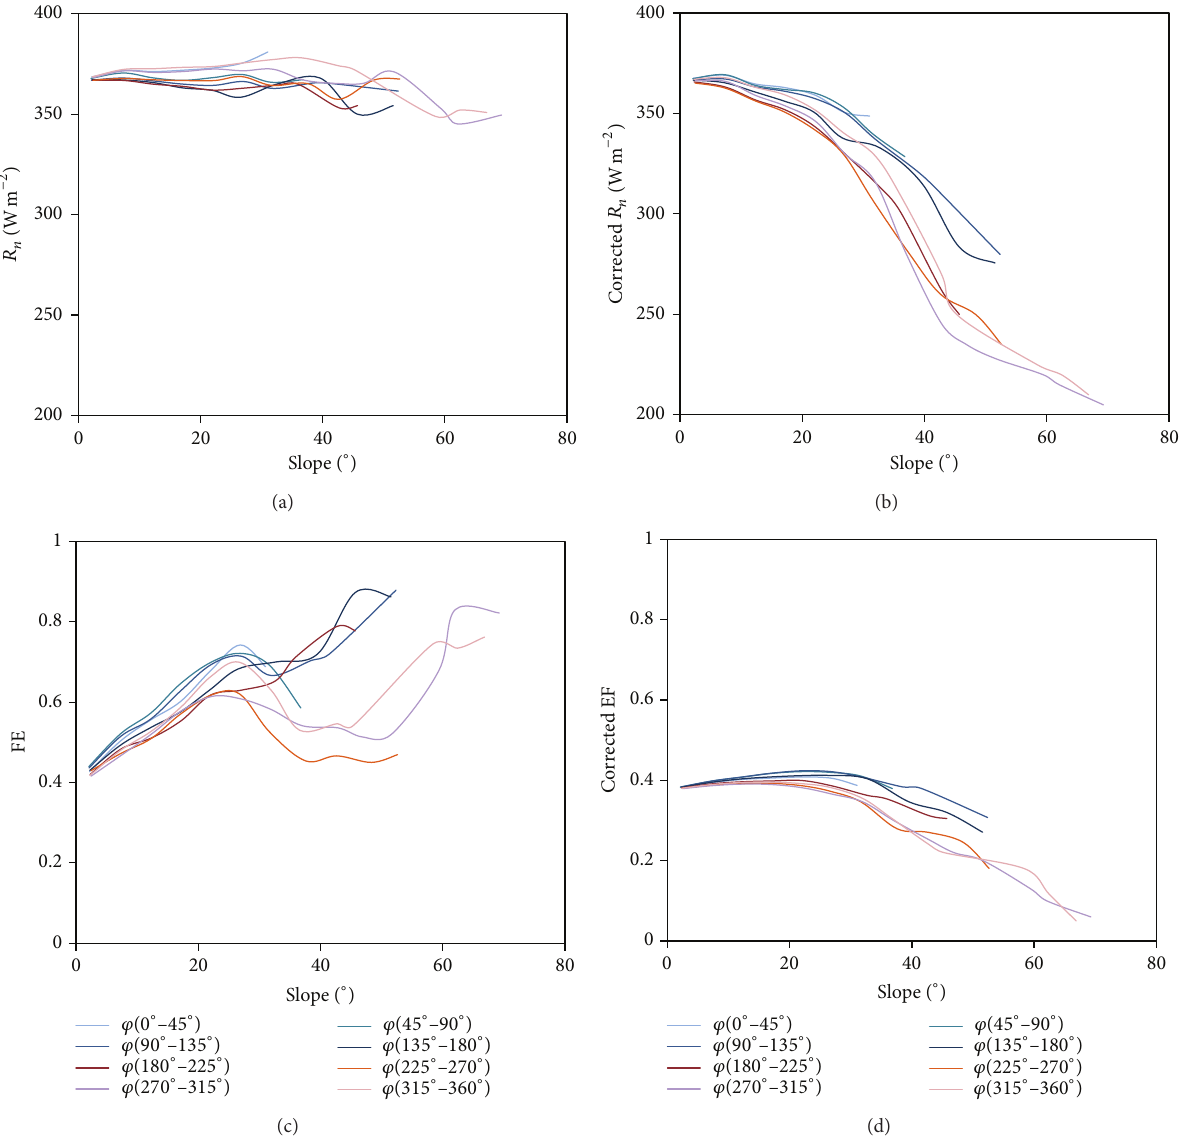
Figure 8: The relationship between 𝑅 𝑛 , EF, and slope for different terrain aspect angles (𝜑) over the selected area of the Taihu Basin. (a) 𝑅 𝑛 before topographic correction, (b)